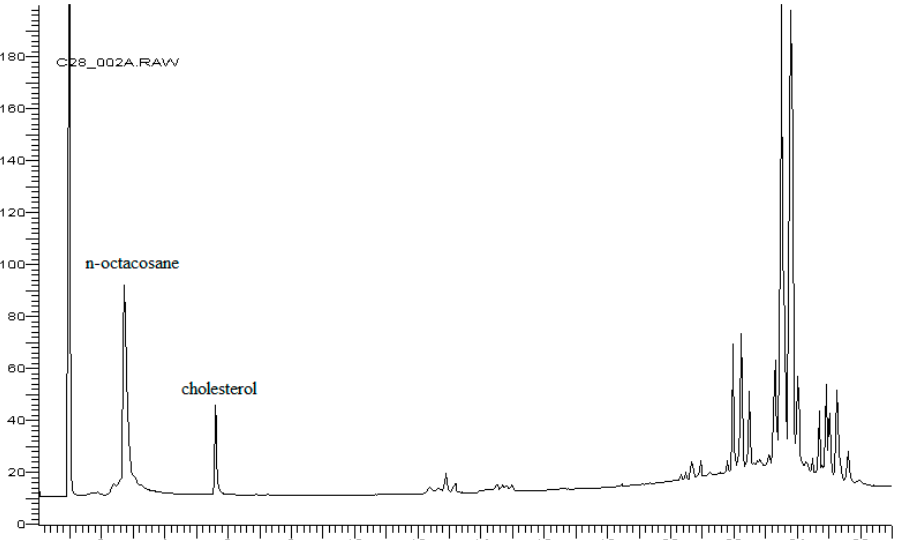
Figure 5. Gas chromatogram of fat extracted from egg yolk with the addition of n ‐ octacosane. Carrier flow: 2.0 mL/min.